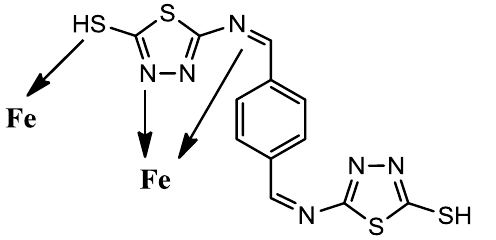
Figure 6. The postulated mechanism of PBB as corrosion inhibitor.